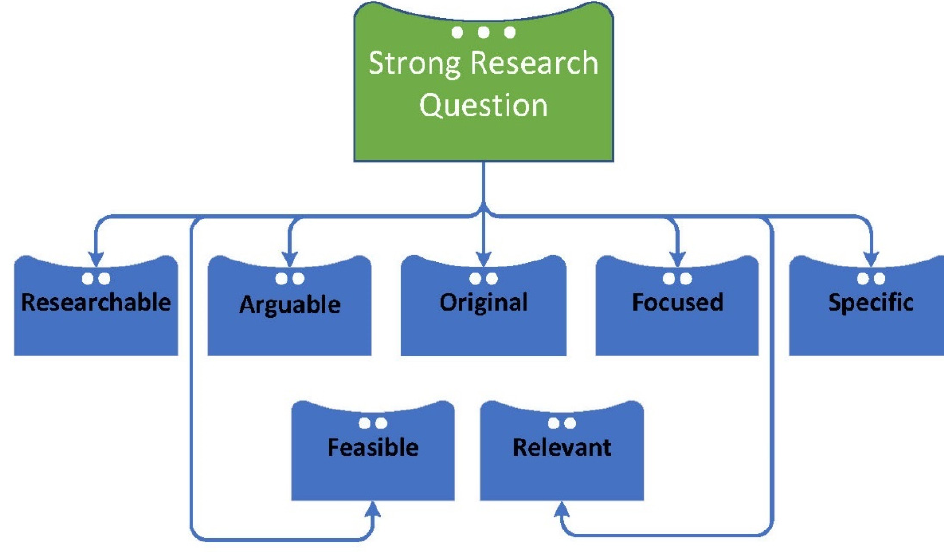
Figure 5. Principles of Strong RQ.